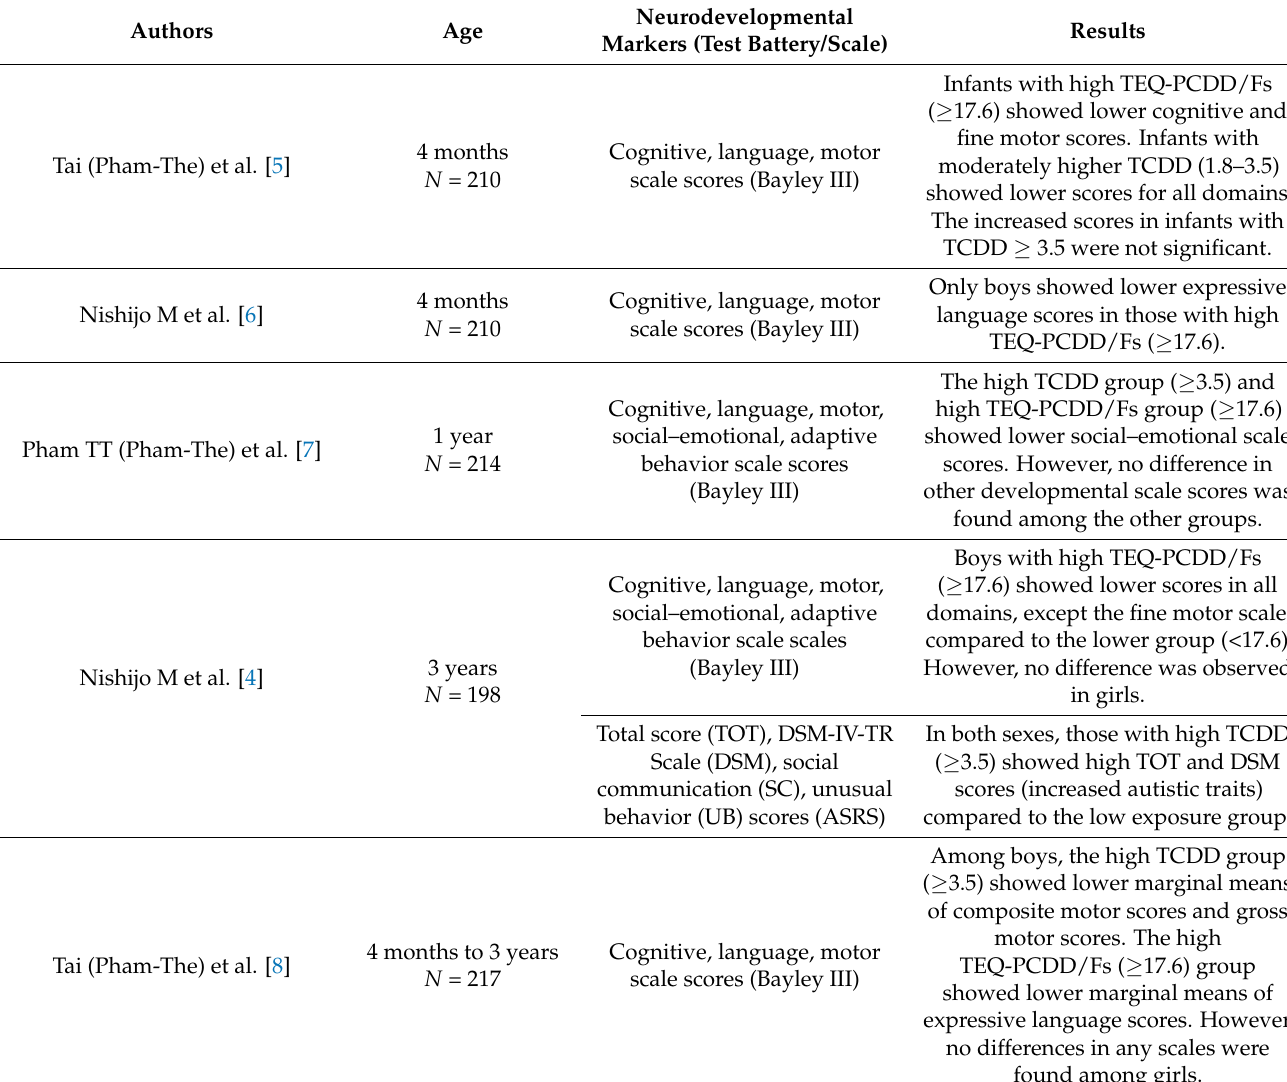
Table 1. Neurodevelopment and perinatal dioxin exposure in infants and children aged 4 months to 3